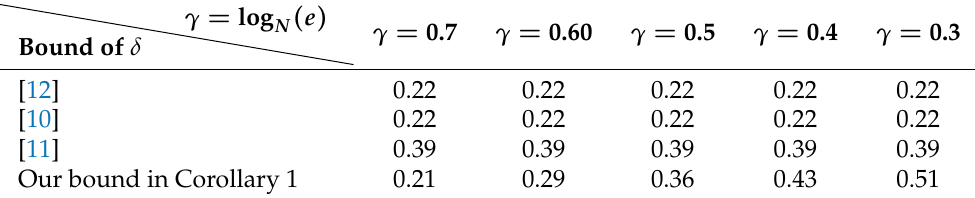
Table 2. Comparison with methods from [10–12] for α = 0.2 and β = 1.